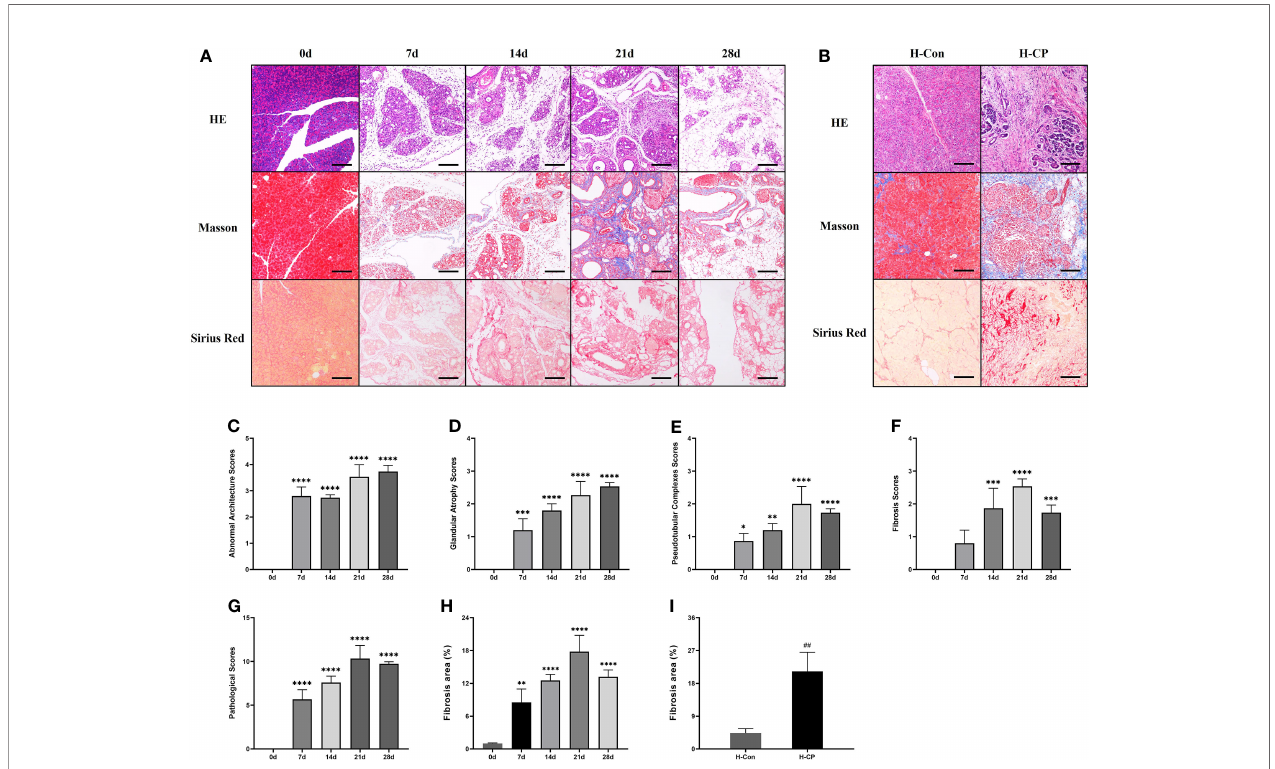
FIGURE 3 | The pancreatic sections of CP mice model induced by ligation of the pancreatic duct showed progressively aggravated glandular atrophy, acinar cell damage, fi brosis, lipomatosis, as well as the formation of pseudobulbar complexes. The pancreatic specimens from CP patients also exhibited obvious fi brosis and parenchymal loss. (A) HE, Masson and Sirius Red staining of pancreas in mice at different time points. (B) HE, Masson and Sirius Red staining of human pancreatic specimens. (C) Pancreatic abnormal architecture scores in mice. (D) Pancreatic glandular atrophy scores in mice. (E) Pancreatic pseudobulbar complexes scores in mice. (F) Pancreatic fi brosis scores in mice. (G) Total pathological scores in mice. (H) Pancreatic fi brosis area in mice. (I) Pancreatic fi brosis area in human specimens. Values are shown as means ± SE. n = 3 per group. *P < 0.05, **P < 0.01, ***P < 0.001, ****P < 0.0001 versus 0d. ## p < 0.01 versus H-Con. Scale bar=150 m m. H-CP, human chronic pancreatitis; H-Con, human